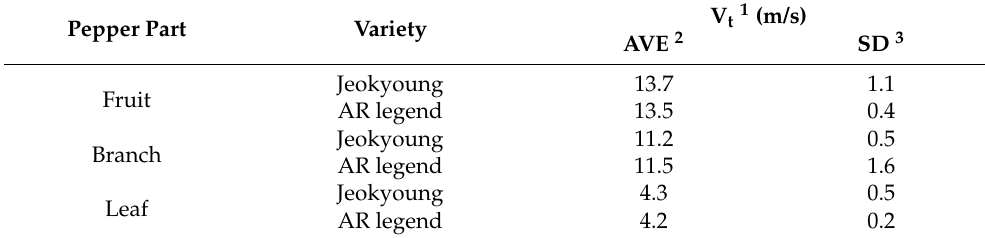
Table 2. Experiment results of pepper terminal velocity.